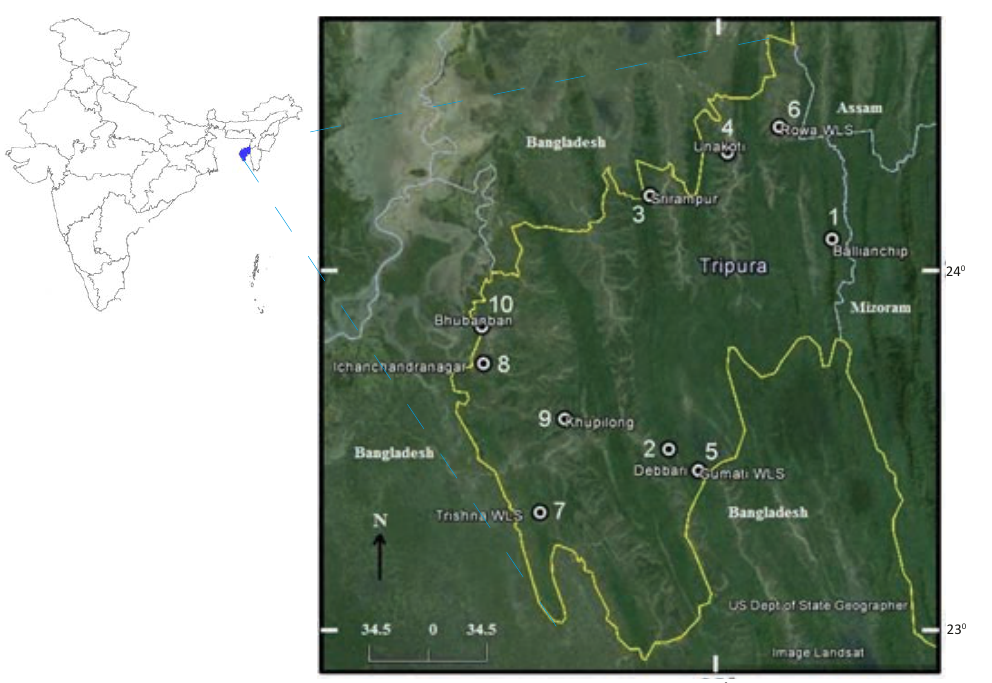
Figure 1. Locations of the study, Tripura